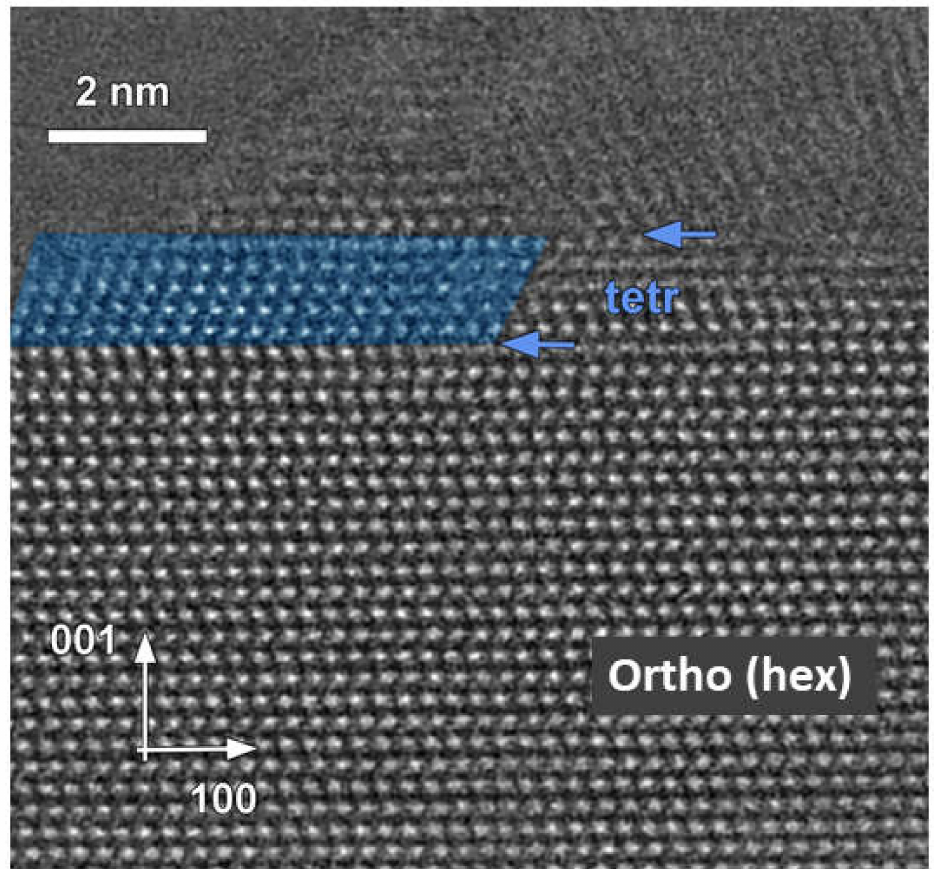
Figure 6. High-resolution HAADF–STEM image of AgInS 2 crystallite prepared via 2-step heating profile, 0.5 mmol metal concentration, and DES. The arrows indicate the phase boundary between orthorhombic and tetragonal (in blue)